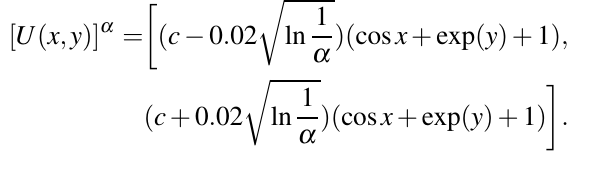
Fig. 5. The curve of fuzzy solutions U ( x , y ) at different val- ues of ( x , y ) .